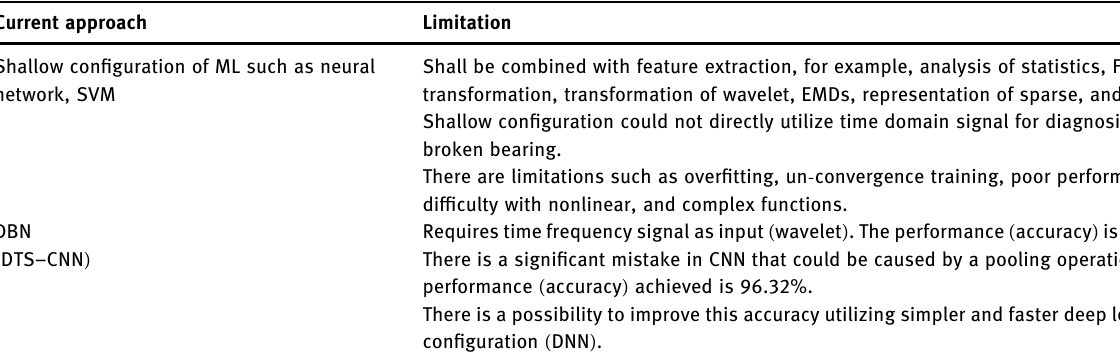
Table 1: Currently available approach of broken bearing diagnosis Current